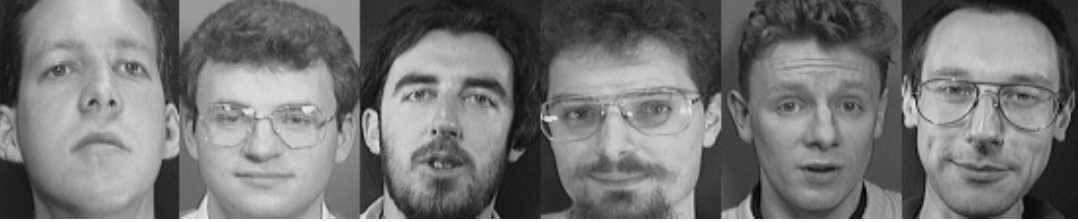
Figure 13. Sample images from the ORL face database.